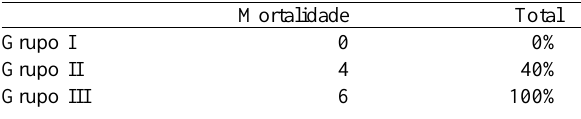
1. Mortalidade operatória dos animais, em números absolutos e em porcentagem, para os grupos I, II e III, após serem submetidos em CEC, a duas horas de isquemia e três horas de reperfusão.